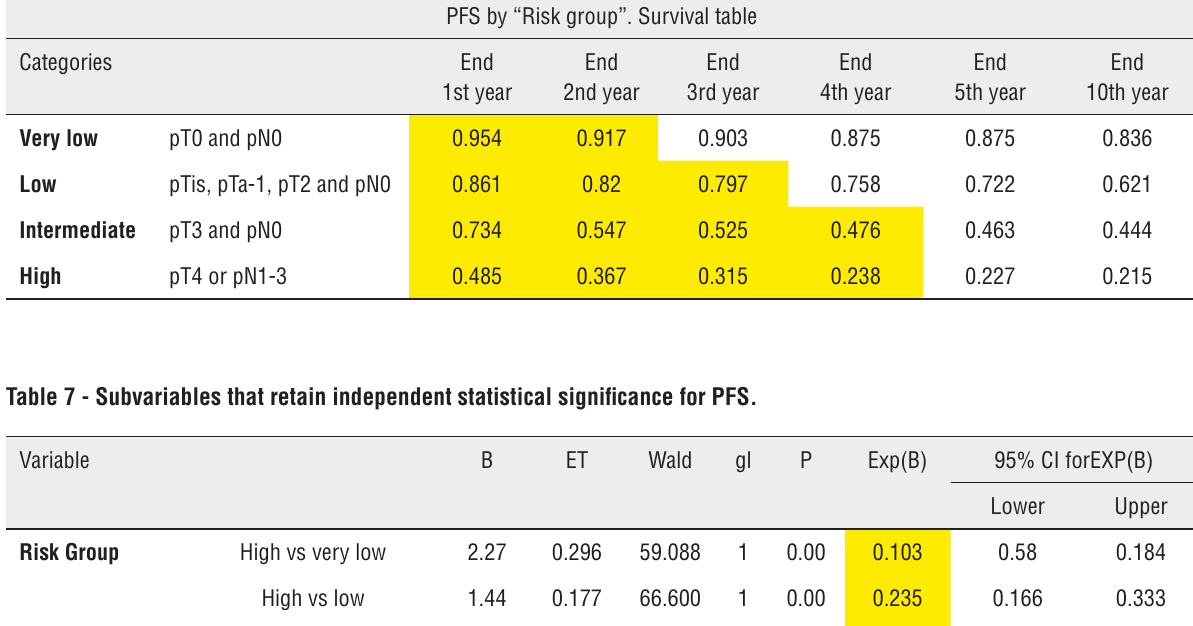
PFS by “Risk group”. Survival table